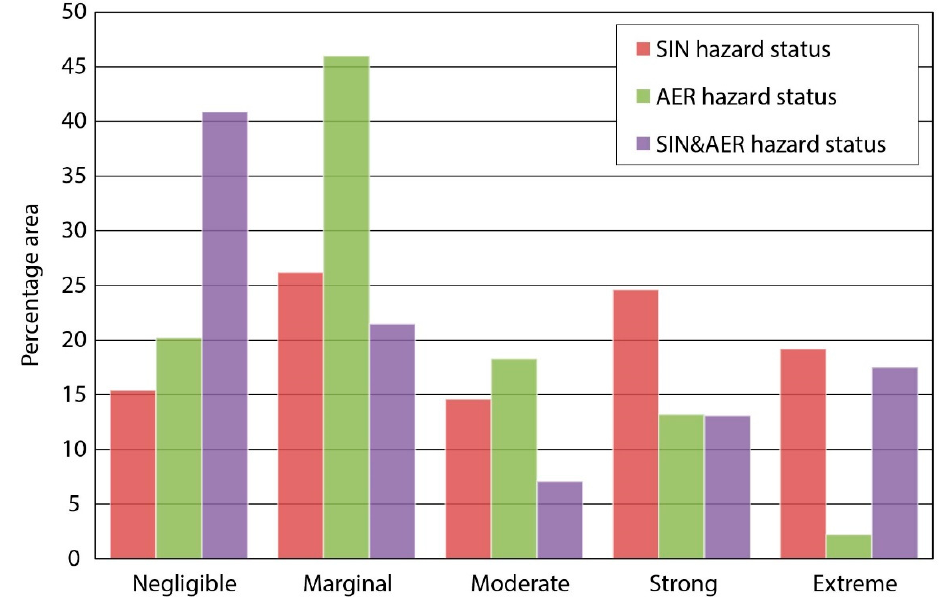
Figure 11. Areal extent of vulnerability classes (%) for the three hazard